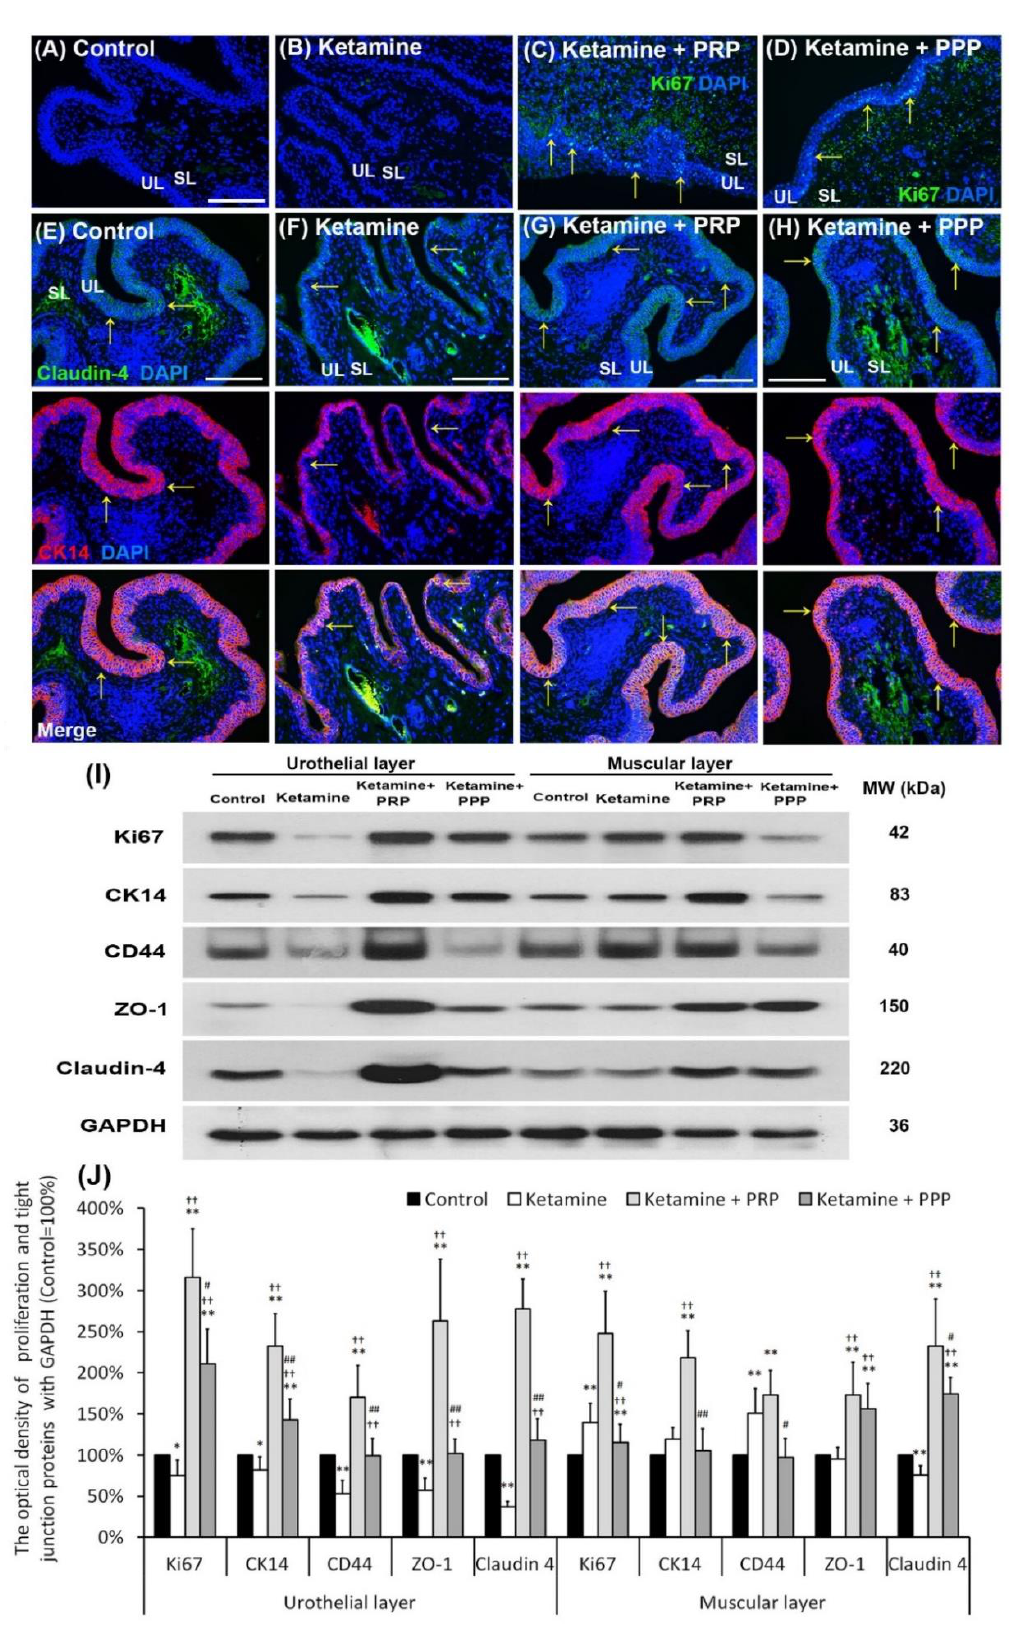
Figure 3. PRP strengthened urothelial proliferation and junction-associated protein expression. The expressions of proliferating and differential marker (Ki67, CK14 and CD44) markers and urothelial